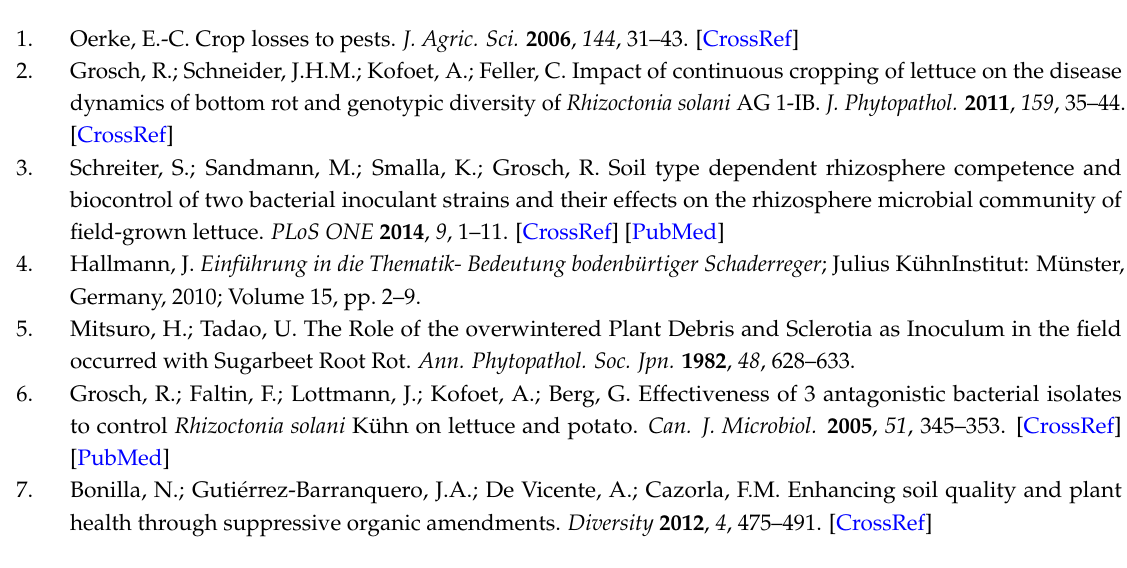
Figure S1. Shoot dry mass of Lactuca sativa L. cv. Tizian. The plants were grown on loess loam without